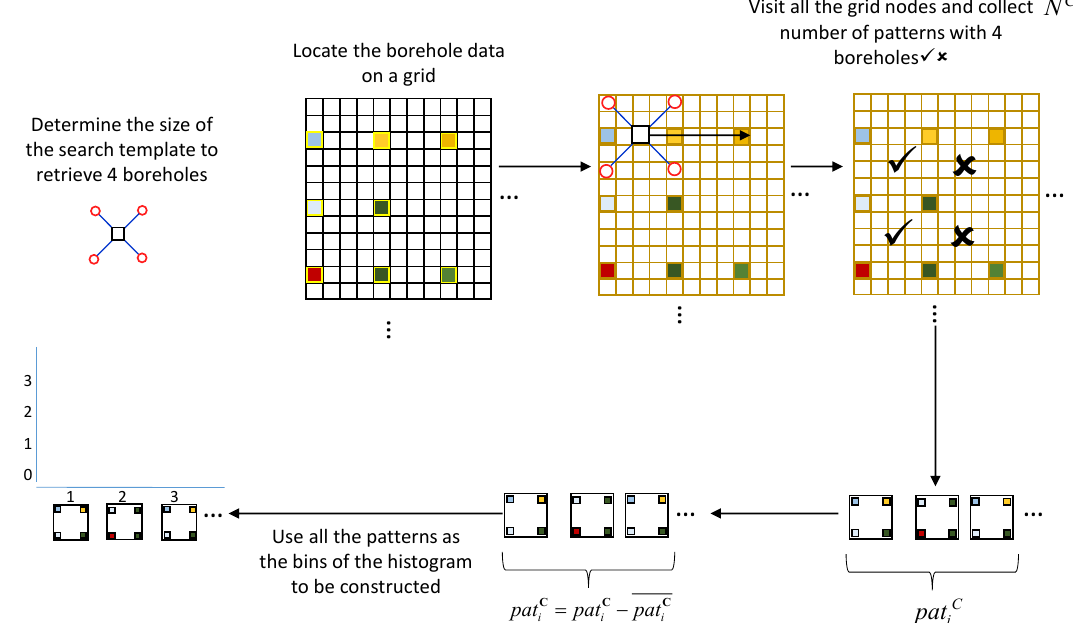
Figure 2. Construction of the smooth histogram categories of the of borehole